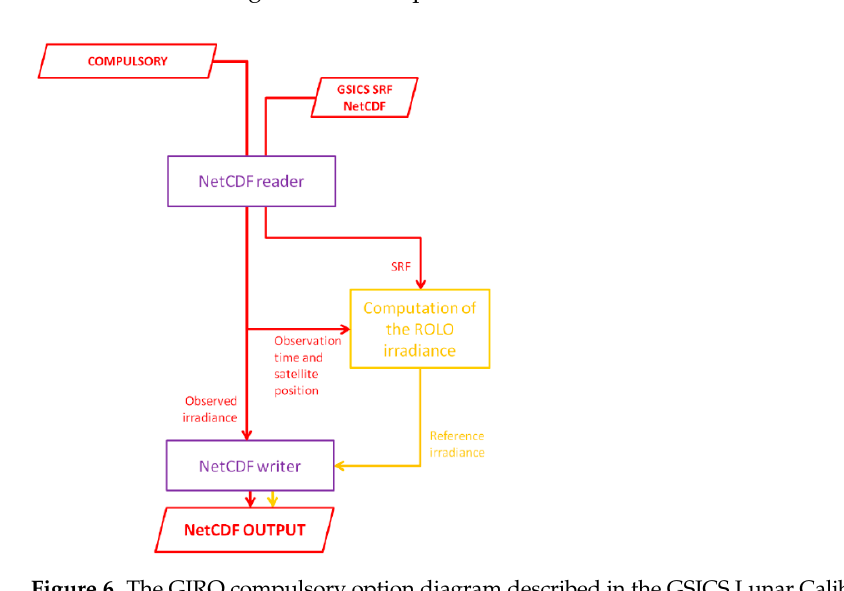
Figure 6. The GIRO compulsory option diagram described in the GSICS Lunar Calibration website at (http://gsics.atmos.umd.edu/bin/view/Development/LunarWorkArea) (accessed on 11 March 2021).